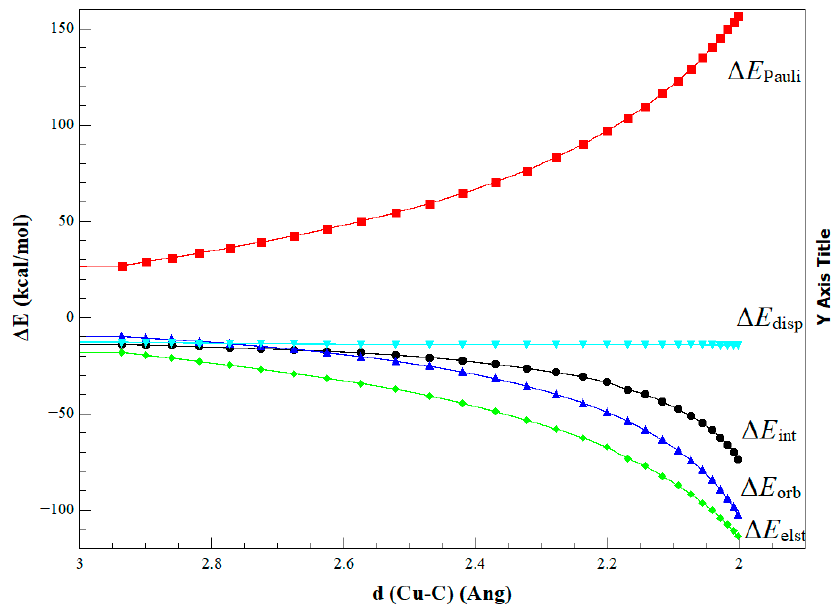
Figure 5. Energy decomposition analysis (EDA) of the interaction energy for the oxidative addition reaction of PhI ( 1 ) to [(phen)Cu I (NHPh)] projected onto the forming Cu–C bond. All data were computed at the BP86 + D3(BJ)/TZ2P +//B3LYP/def2-SVP level.